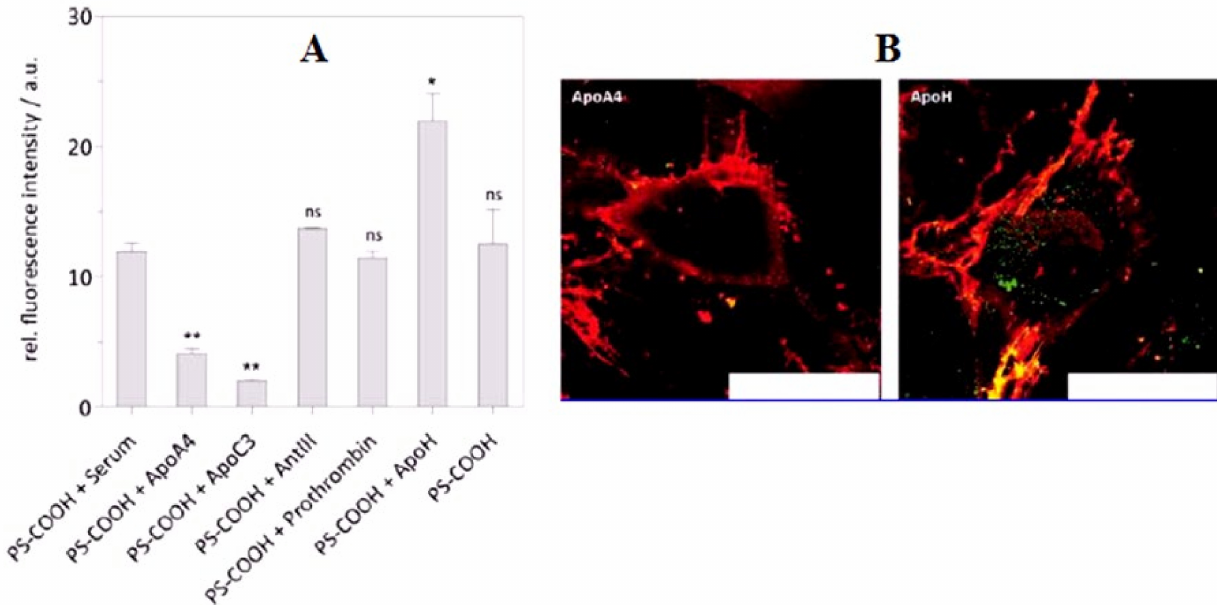
Figure 8. Impact of the single protein surfacing on nanoparticle cell uptake in hMSCs. ( A ) The polystyrene nanoparticle (carboxy functionalized, PSCOOH) was coated with ApoA4, ApoC3, AntIII, prothrombin, or ApoH (50 µ g per 0.05 m 2 , 1 h, 37 ◦ C), and incubated for 6 h in a serum-free medium. Error bars ± SEM estimated with two experiments in triplicate ( n = 3). Level of significance (* p < 0.05; ** p < 0.01). ( B ) Accompanying confocal microscopy images of living hMSCs treated with ApoA4 or ApoH-coated carboxy functionalized polystyrene nanoparticle. Plasma membrane stained with cell mask orange (red) and nanoparticles labeled with Bodipy-1. Scale bars = 75 µ m. Adapted, with permission, from